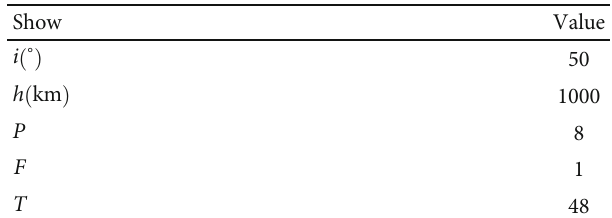
Figure 12: Results for polar COB. Table 5: